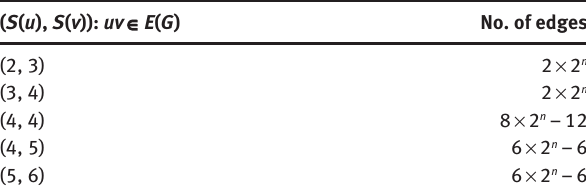
Table 1: Edge set partition of PETIM dendrimer based on sum of degrees of neighbors of end-vertices of every edge.